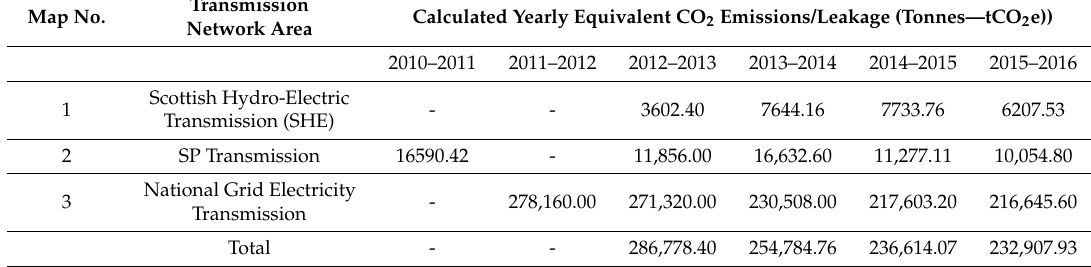
Table 8. Calculated equivalent transmission network area SF 6 emissions (tCO 2 e) (scale factor: 1 kg SF 6 = 22,800 kg CO 2 ). Map No.